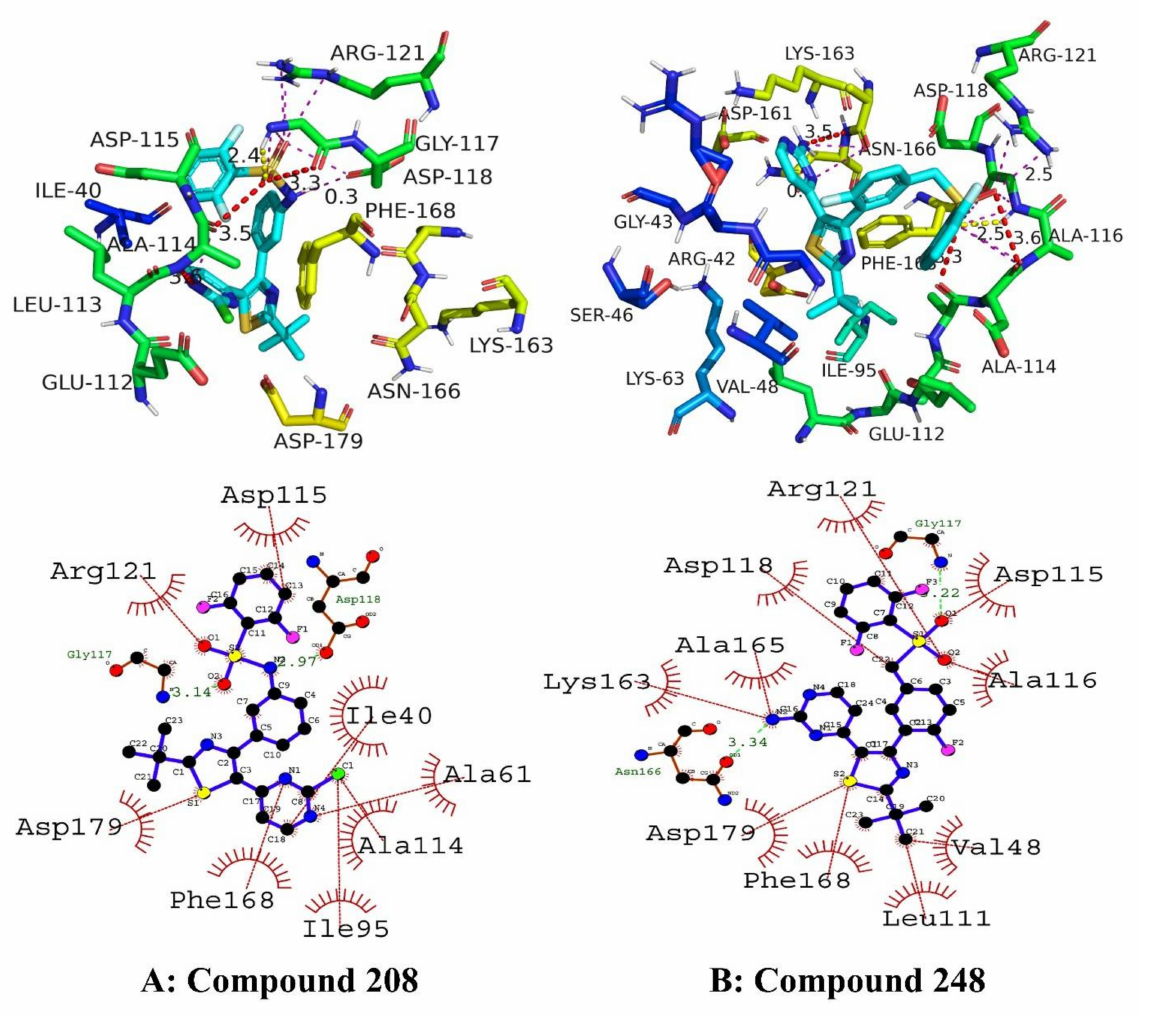
Figure 5. The putative 2D and 3D binding mode of compound 208 ( A ) and 248 ( B ). Green dashes are indicating hydrogen bonding whereas red dashes are indicating hydrophobic